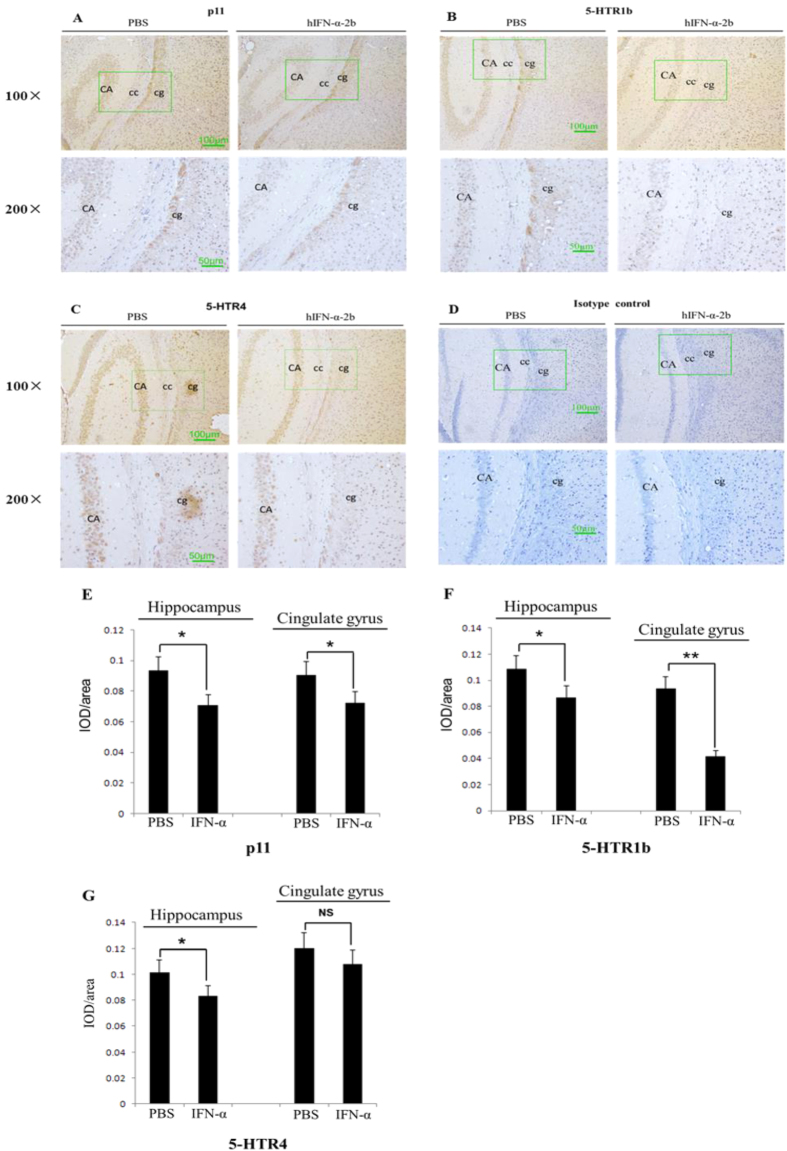
Immunohistochemistry tests assayed the p11, 5-HTR1b and 5-HTR4 protein levels in the hippocampus or cingulate gyrus in hIFN-α-2b (or PBS)-treated Balb/c mouse.(A–C) Maps of the brain tissues showed the protein levels in the hippocampus (CA) or cingulate gyrus (cg), where cc represented the corpus callosum. (D) Isotype control for immunohistochemistry using rabbit IgG instead of the primary antibody. Each image comprised four micrographs (A–D), where left side of the image showed the PBS treatment group and right side of the image showed the hIFN-α-2b treatment group; upstream with 100× visual fields and downstream with 200× visual fields, which corresponded to the areas in the 100× micrographs marked by green-line boxes. (E–G) Integrated optical density (IOD) in the positive areas of the mouse hippocampus or cingulate gyrus, which were measured using “Image Improplus 6.0” software. The IOD/area values were shown in the histogram. (E) hIFN-α-2b treatment reduced the p11 protein levels in the hippocampus and cingulate gyrus compared with the controls. (F) hIFN-α-2b treatment decreased the 5-HTR1b protein levels in the hippocampus and cingulate gyrus compared with controls. (G) hIFN-α-2b treatment decreased the 5-HTR4 protein levels in the hippocampus but not in the cingulate gyrus compared with the controls. Each group, n = 6; scale bar = 100 μm in 100× micrographs, scale bar = 50 μm in 200× micrographs. The data represented the mean ± S.E. compared with the controls. *P < 0.05 and **P < 0.01, and NS, no significant difference.